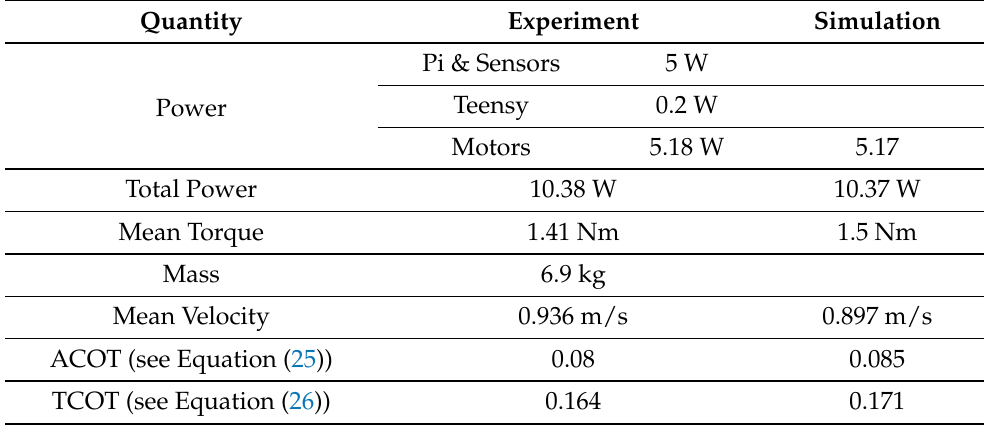
Table 1. Comparison of experiment (mean values) on concrete with simulation for torso pitch set-point of 50 ◦